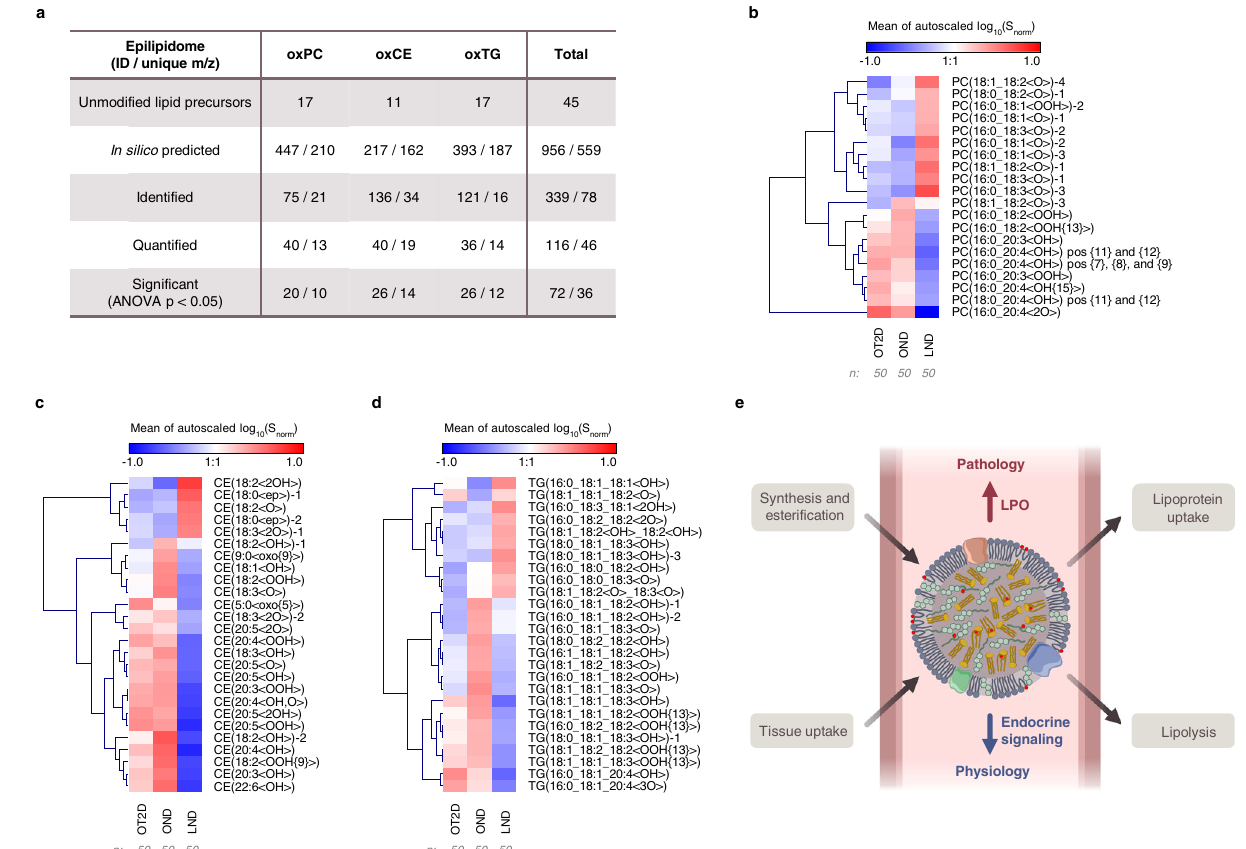
Fig.5|Quanti fi cationofoxidizedcomplexlipidsinbloodplasmalipidextracts of lean non-diabetic (LND), obese non-diabetic (OND) and obese with type 2 diabetes (OT2D) individuals. In silico prediction of sample-speci fi c epilipidome, its identi fi cation using stDDA followed by PRM-based targeted quanti fi cation allowed to annotate and quantify oxidized lipids with signi fi cant differences between three phenotypes ( a ). Heatmaps illustrate lean (LND), obese (OND) and